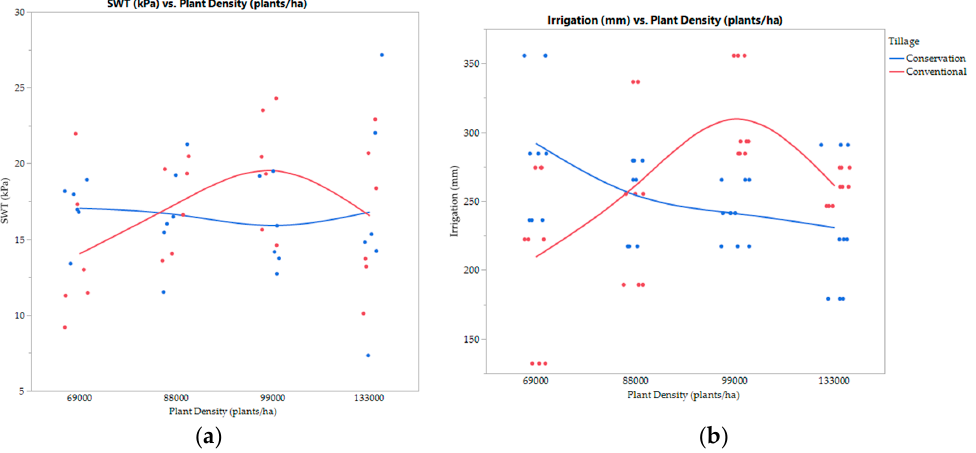
Figure 9. Correlation between ( a ) SWT (kPa), and ( b ) irrigation (mm) with plant density and tillage method in SIRP